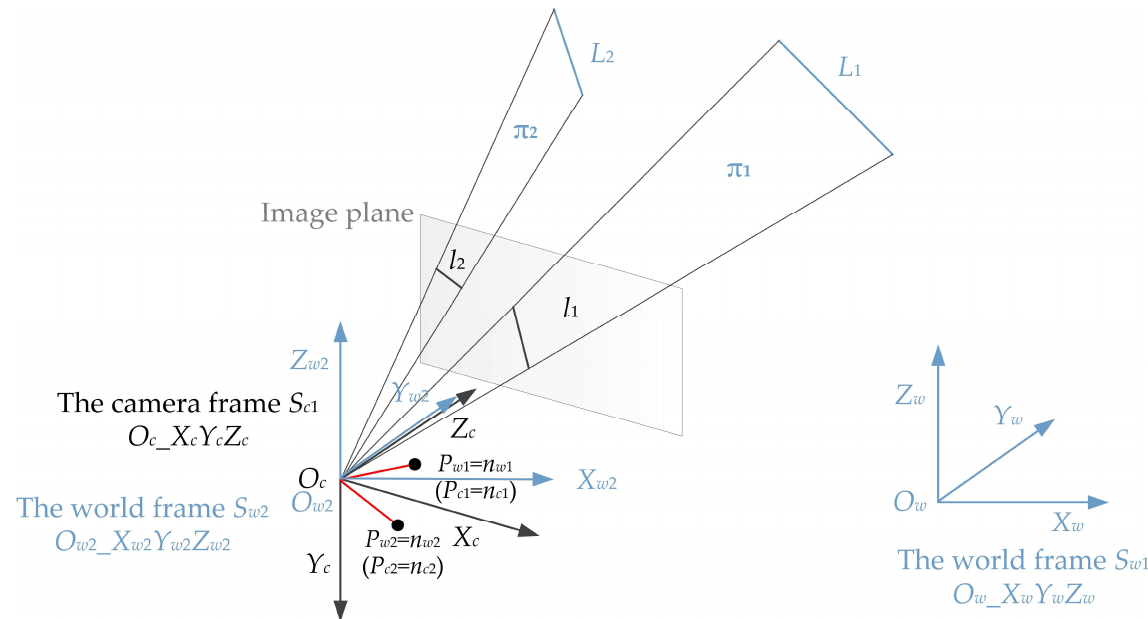
Figure 2. The geometry of our proposed method for pose estimation.